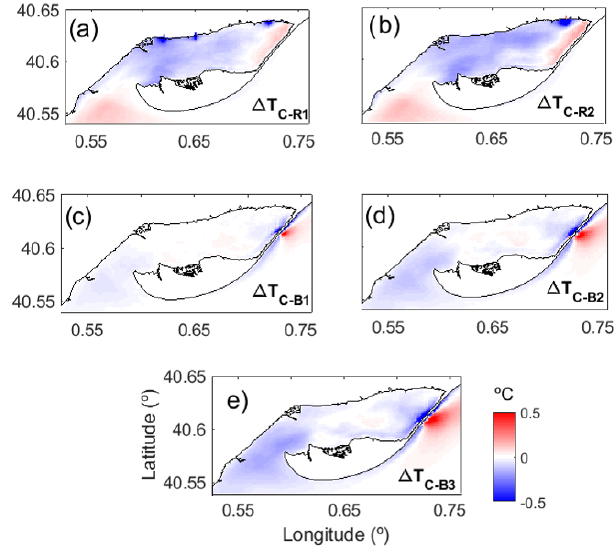
Figure 6. Differences for the SST between each test case and the control simulation (C). Blue indicates a lower SST for the corre- sponding test compared with C (red indicates a lower SST for the control